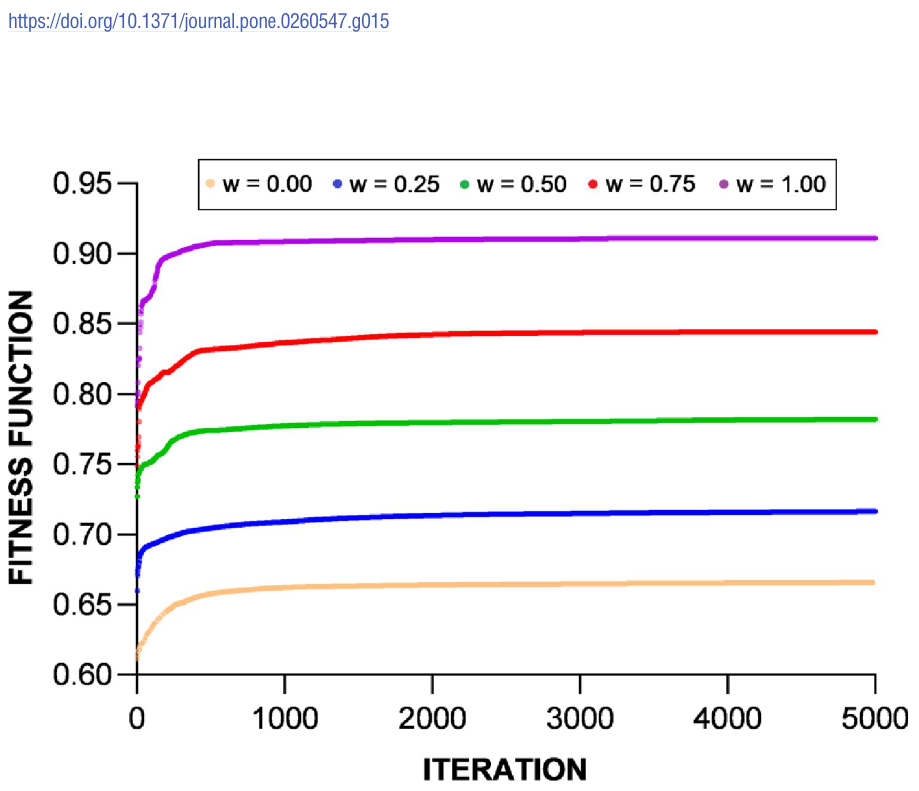
Fig 16. The convergence of the values of the fitness function in five scenarios under the AC priority operation mode.